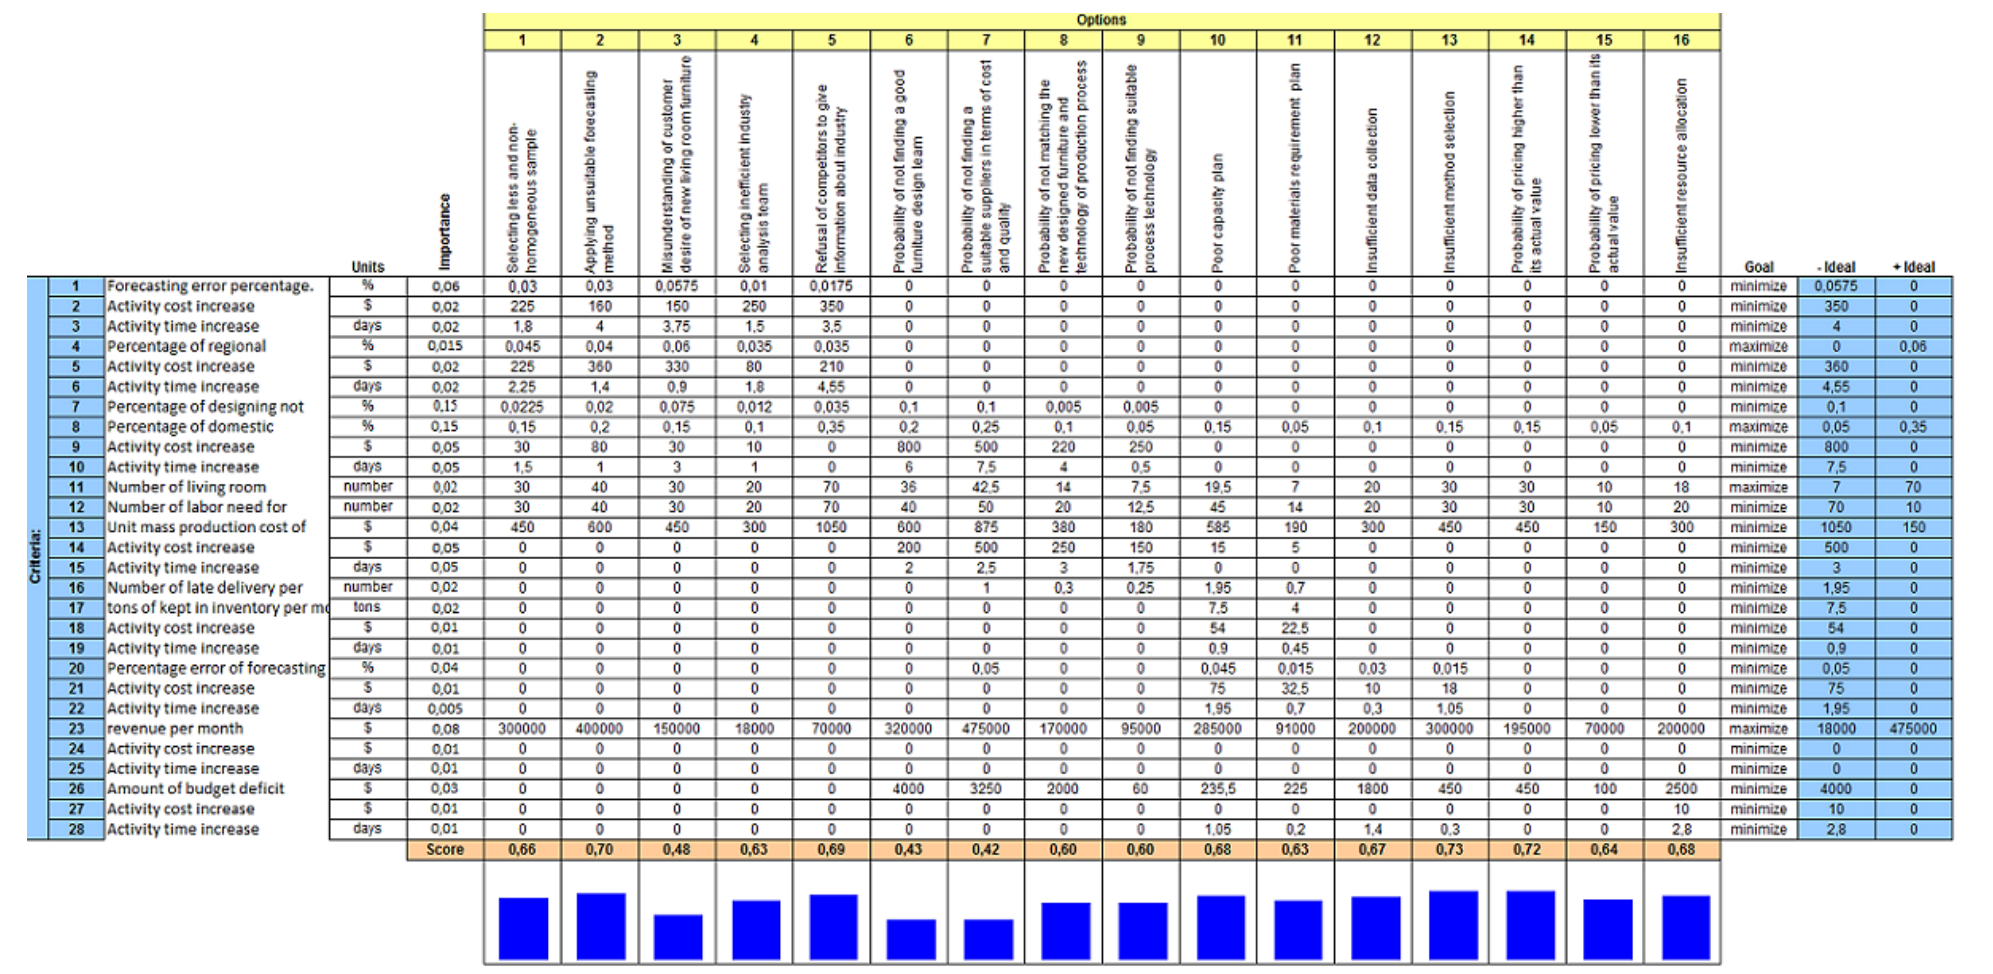
Table 11. TOPSIS table and solution scores of application